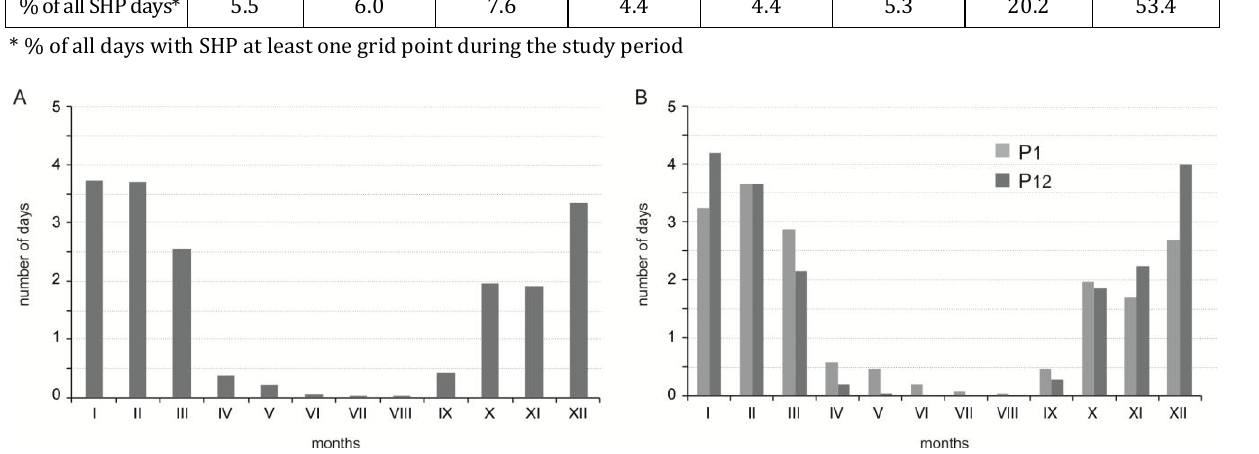
Fig. 4. Average monthly number of days with SHP for 12 (A) and at selected (B) grid points in the period